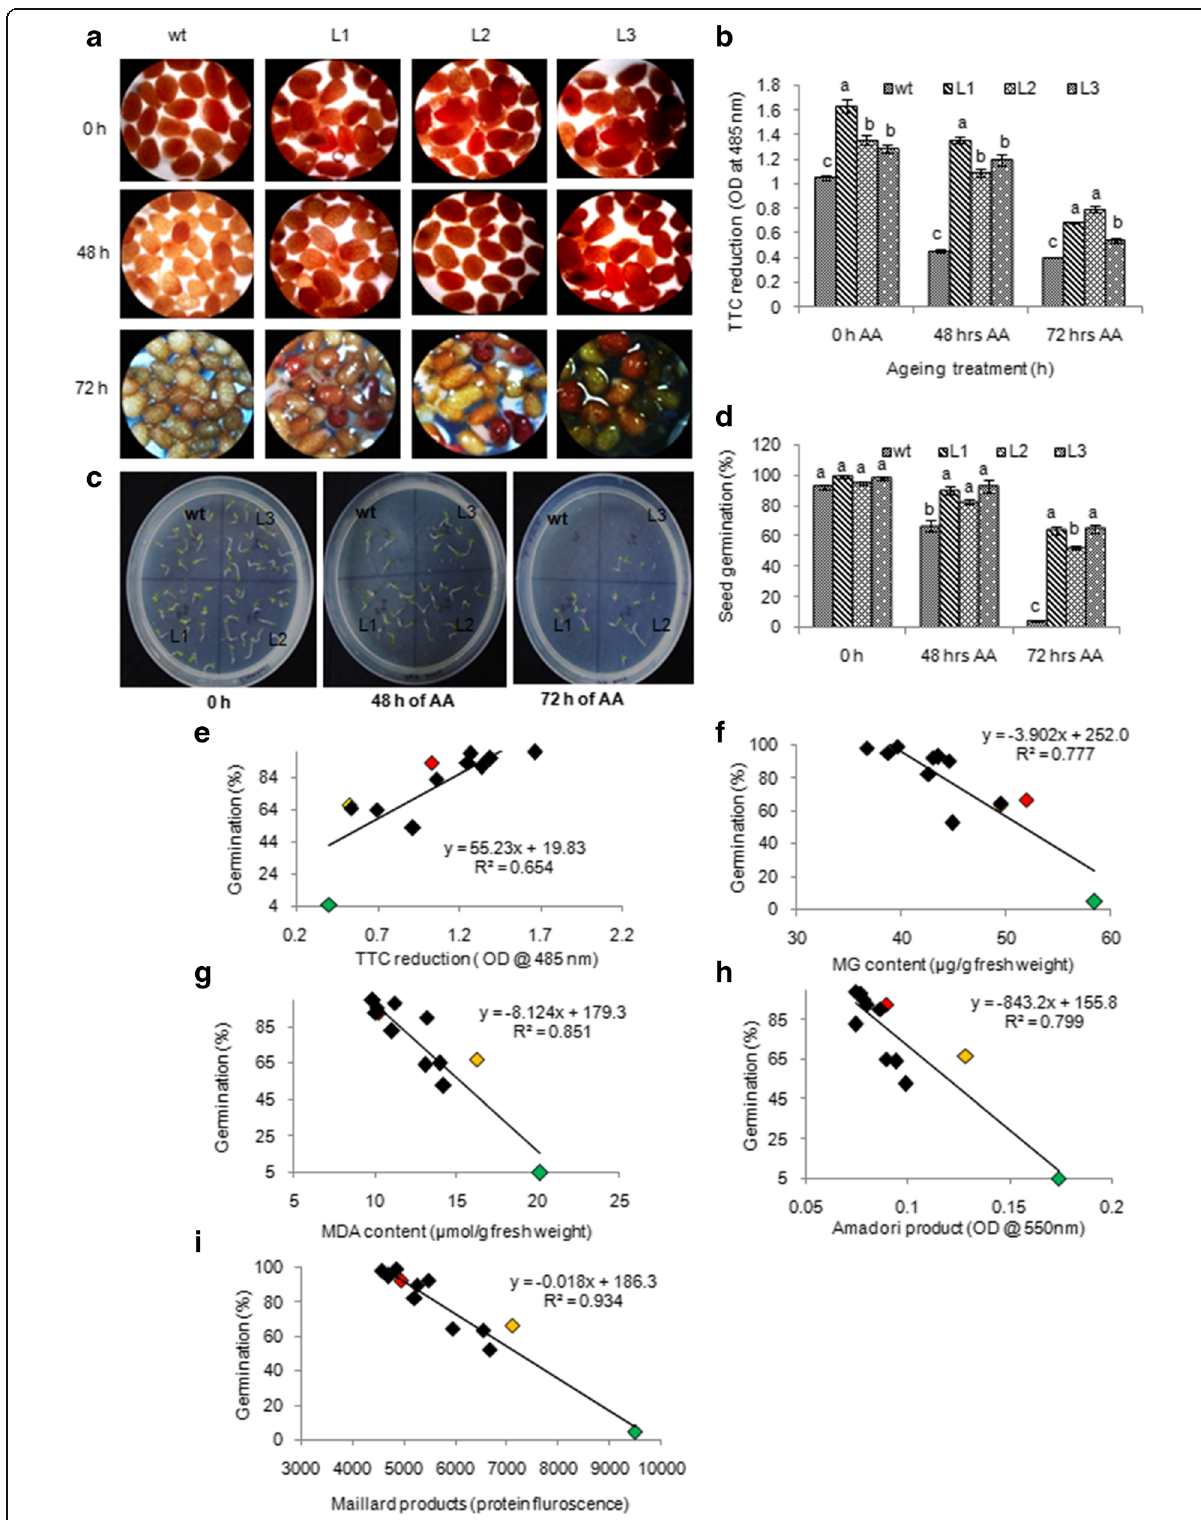
Fig. 3 (See legend on next